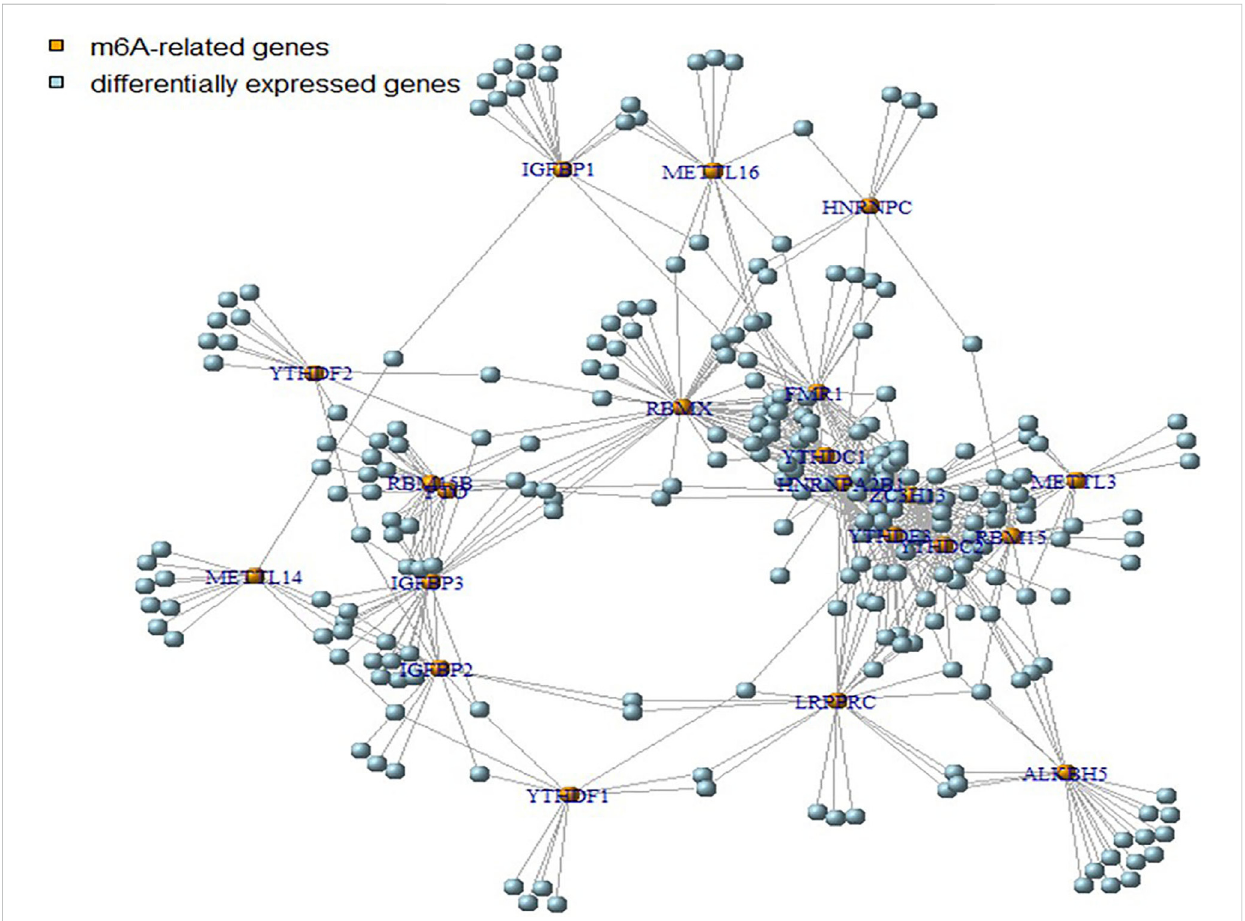
FIGURE 2 Screening for m6A-related DEGs. Red dots represent genes involved in m6A modi fi cation, blue dots represent DEGs, and lines represent the correlation between